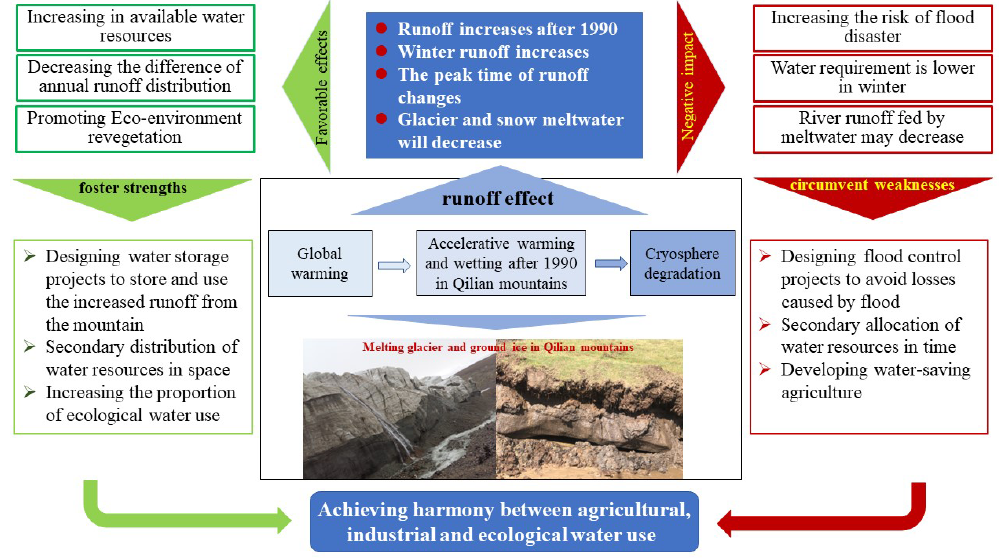
Figure 16. Conceptual model of runoff change, water resource effect, and countermeasures under global warming in the Qilian Mountains.